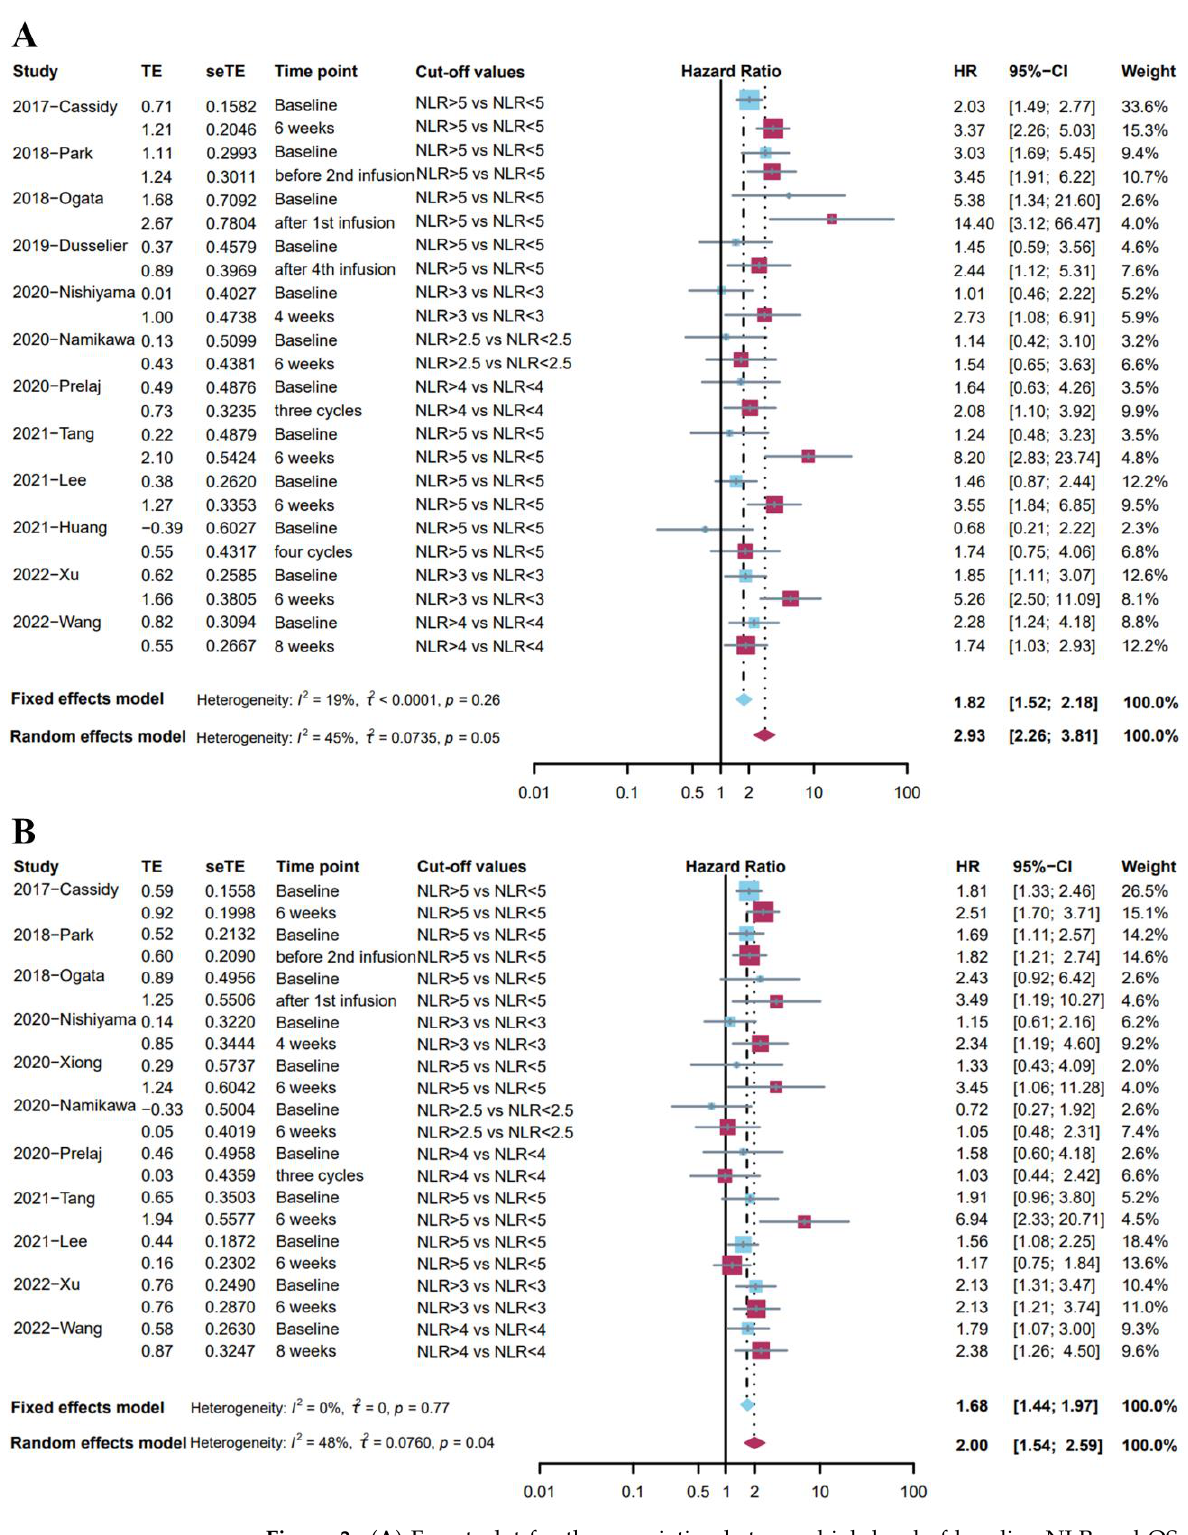
Figure 3. ( A ) Forest plot for the association between high level of baseline NLR and OS (blue); the association between high level of post-treatment NLR and OS (red). ( B ) Forest plot for the association between high level of baseline NLR and PFS (blue); the association between high level of post-treatment NLR and PFS (red).